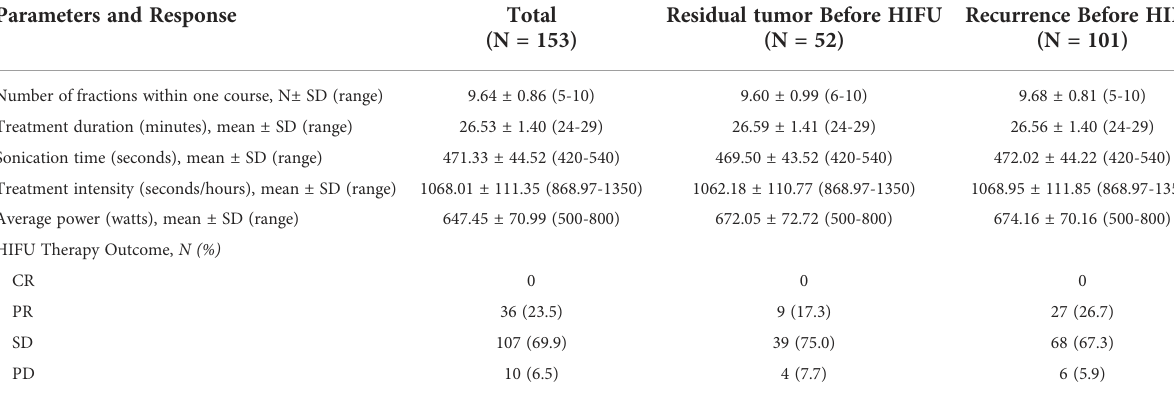
TABLE 2 HIFU ablation parameters and treatment response.